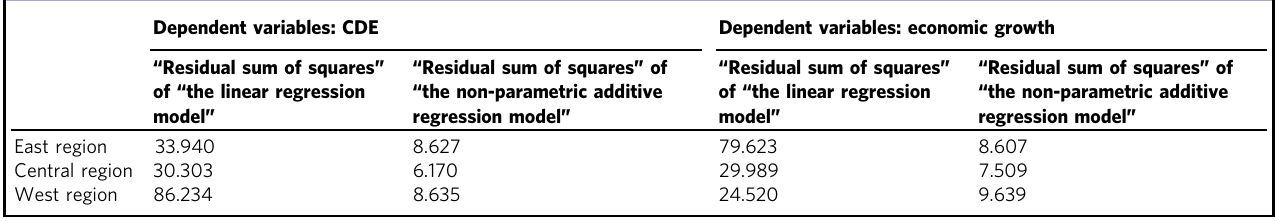
Table 4 “ Residual sum of squares ” of “ the non-parametric additive regression model ” and “ the linear regression model ” . Dependent variables: CDE